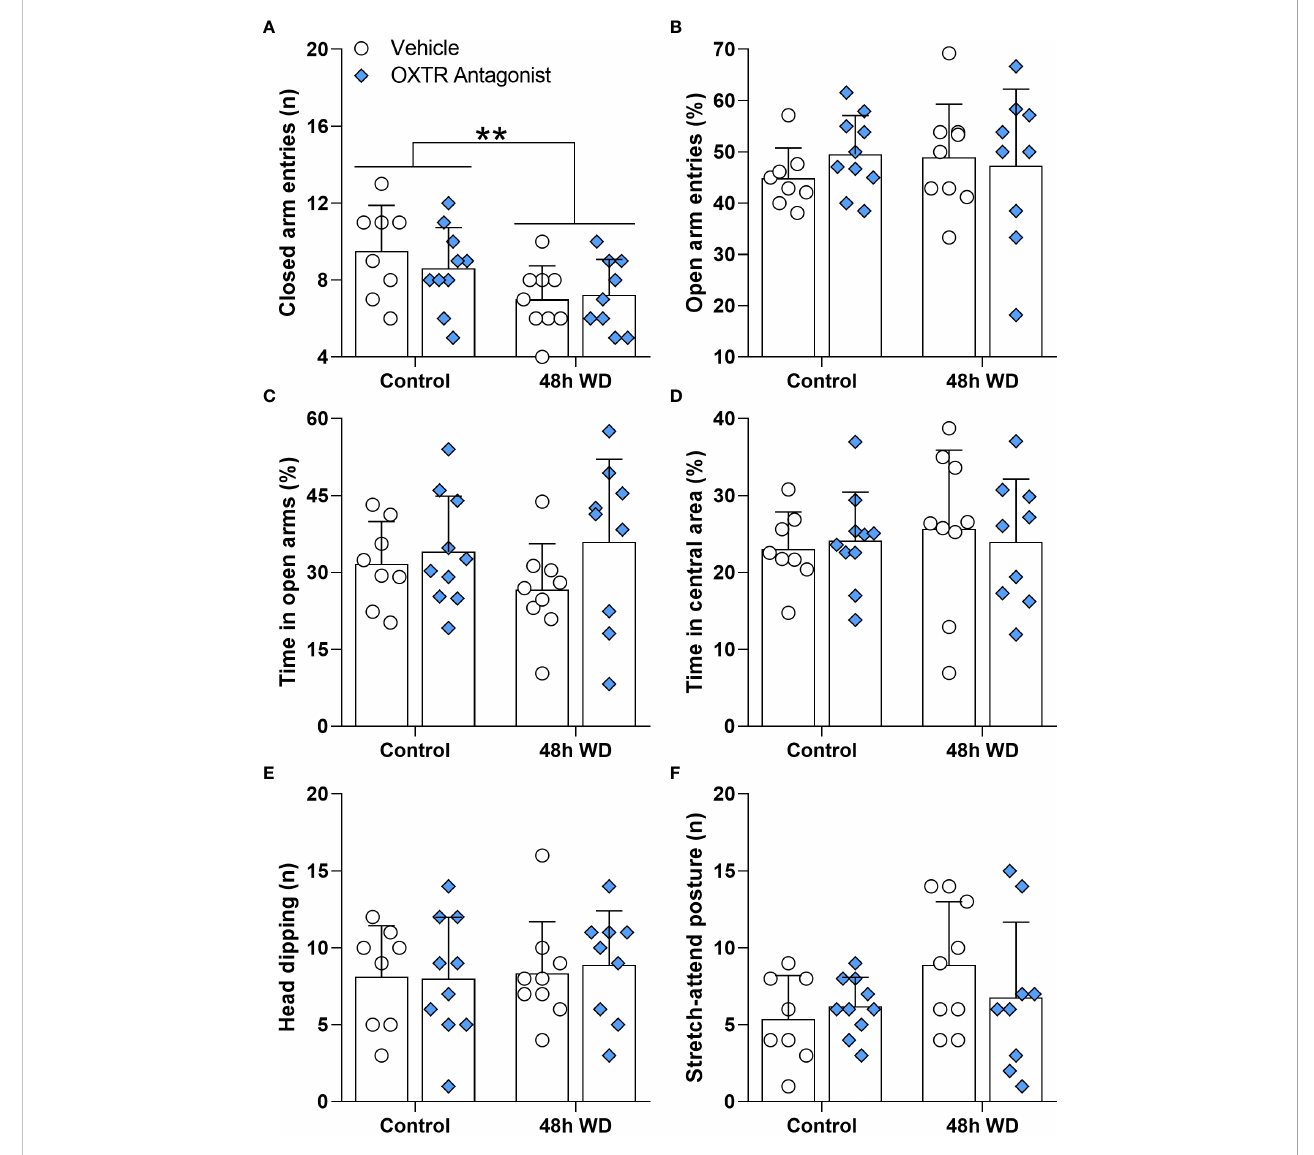
FIGURE 6 Effects of oxytocin receptor antagonist microinjection in the central amygdala of 48-h water-deprived male adult rats on (A) number of entries into closed arms, (B) percentage of entries into open arms, (C) percentage of time spent in open arms, (D) percentage of time spent in the central area, (E) number of head dipping episodes, and (F) number of stretch-attend postures during 5 min of evaluation in the elevated plus maze apparatus. Values are mean ± SD. The number of animals used per group was: Control + vehicle = 8; Control + antagonist = 10; 48 h WD + vehicle = 9; 48 h WD + antagonist = 9. Data were submitted to two-way ANOVA. The values of the number of stretch-attend postures were transformed to ranks before ANOVA. **p<0.01 comparing Water Deprived vs . Control